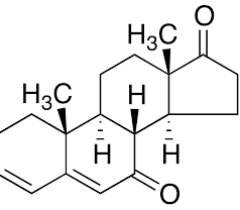
Figure 4. Chemical structure of arimistane. Formula: C 19 H 24 O 2.